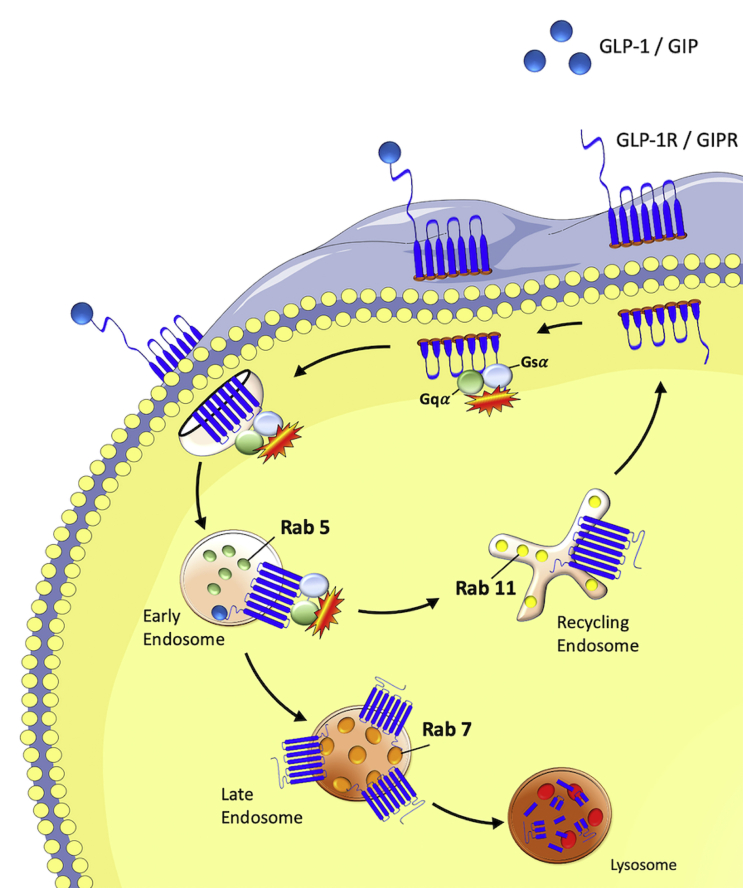
Schematic of the endosomal marker associated with GLP-1R/GIPR internalization and trafficking. Markers indicative of endosomal trafficking include Rab5 (early endosome), Rab7 (late endosome), and Rab11 (recycling endosome).